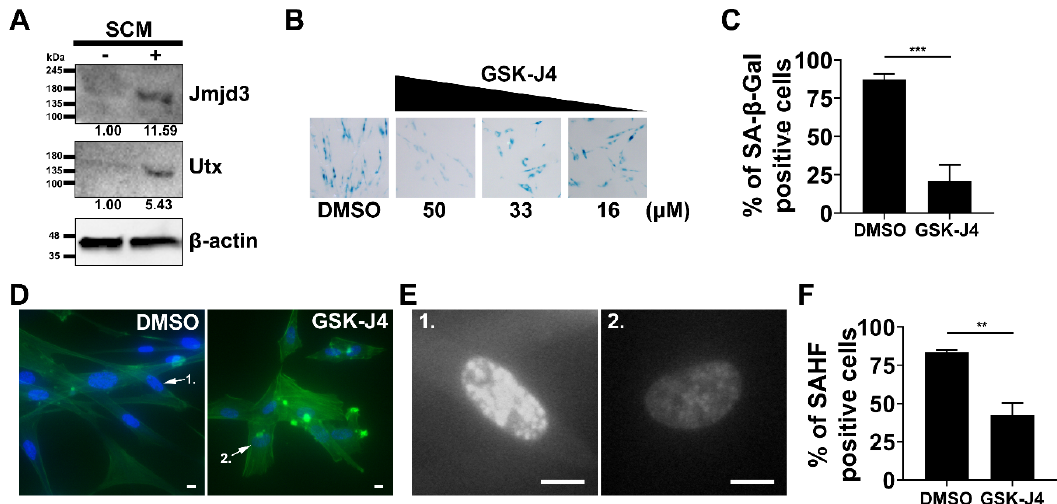
Figure 4. Chemical inhibitor GSK-J4 blocks the e ff ects of SCM. ( A ) Western blot showing Jmjd3 and Utx levels in MRC5 cell lysates after 48 h in SCM. The number below each band is the densitometry value (intensity ratio) compared to β -actin and relative to the control condition. ( B ) MRC5 cells simultaneously treated with SCM and GSK-J4 at di ff erent concentrations. Representative images for SA- β -gal staining at 48 h. DMSO was the vehicle control. ( C ) Quantification of SA- β -gal shown in B for 50 µ M of GSK-J4 compared to DMSO. ( D ) Representative images MRC5 cells stained for the nucleus (blue) and F-actin (green). Cells were treated simultaneously with SCM and GSK-J4 (50 µ M) for 72 h. (Scale Bar, 10 µ m). ( E ) Cell nuclei 1 and 2 from D are enlarged and presented in greyscale (Scale Bar, 10 µ m). ( F ) Quantification of cells with SAHF at 72 h. ( C , F ) Student’s t -test; bars represent standard deviation and asterisks indicate statistical significance (**, p ≤ 0.01; ***, p ≤ 0.001; n = 3).